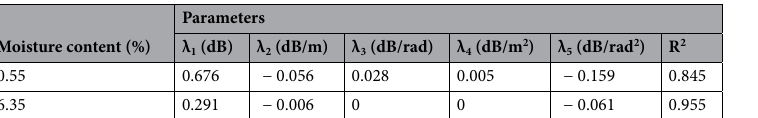
Moisture content